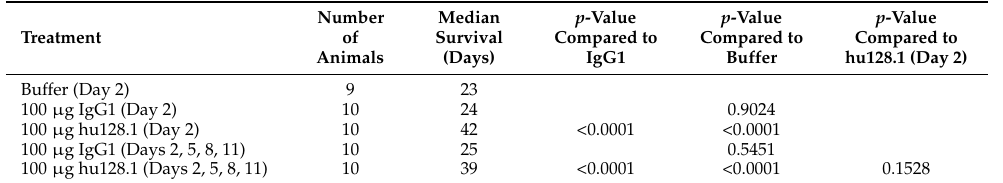
Figure 3. Disseminated model of AIDS-NHL using 2F7-BR44 cells. SCID-Beige mice were challenged i.v with 5 × 10 6 cells via the tail vein. ( A ) Mice were treated i.v. on Day 2 after tumor challenge with 100 µ g isotype negative control antibody (IgG1) or ch128.1/IgG1 ( n = 7 per group). ( B ) Treatment schedules are indicated. Kaplan-Meier survival plots are shown. Median survival and the results of the statistical analysis for panel B are shown in Table 2 ( n = 9 or 10 per group). Table 2. Median survival and statistical analysis for the data in the disseminated model of AIDS-NHL using 2F7-BR44 cells presented in Figure 3B.